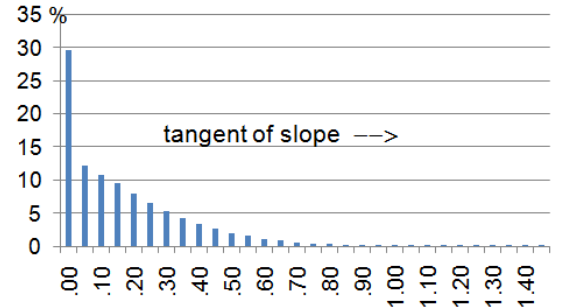
Fig. 2: Frequency distribution of terrain slope